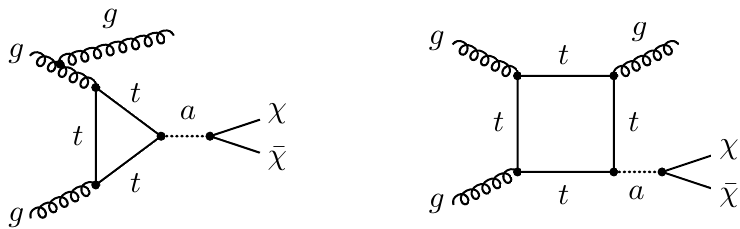
Figure 7 . Examples of diagrams that give rise to a j + E T; miss signature through the exchange of a lighter pseudoscalar a . Graphs involving a heavier pseudoscalar A also contribute to the signal in the pseudoscalar extensions of the THDM but are not shown